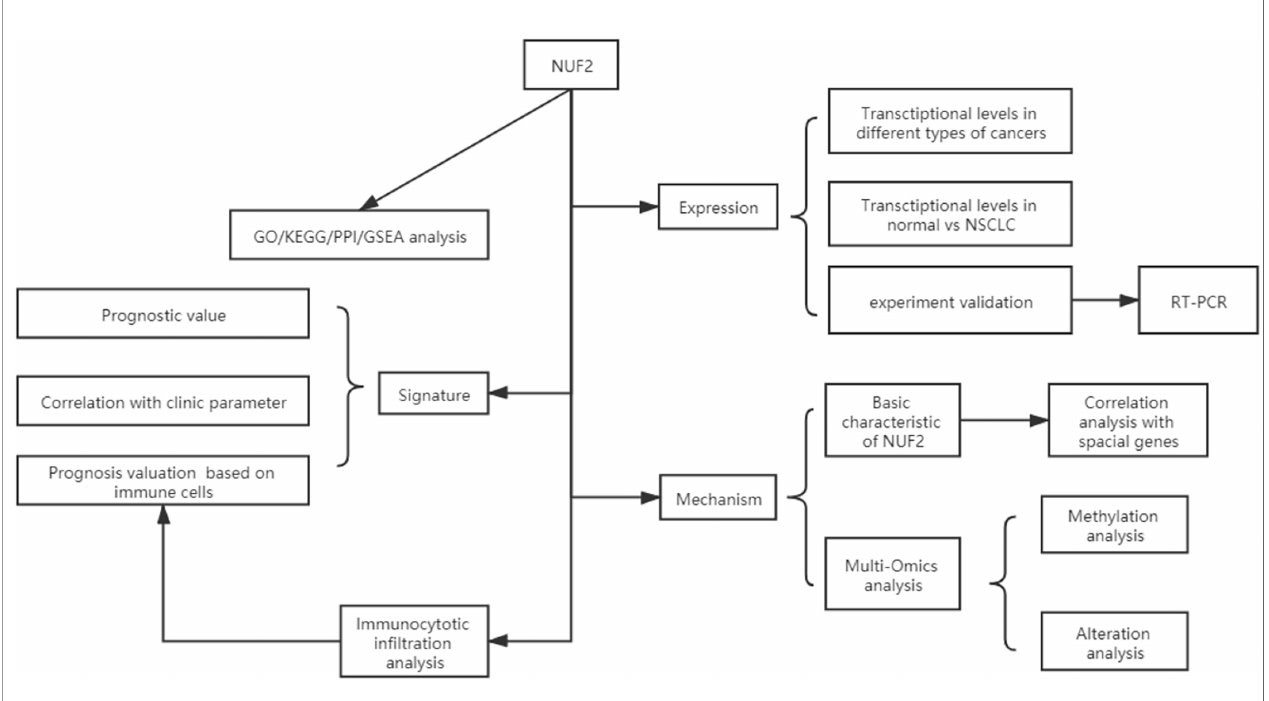
FIGURE 1 | Flow diagram of data collection and method implementation in this work.